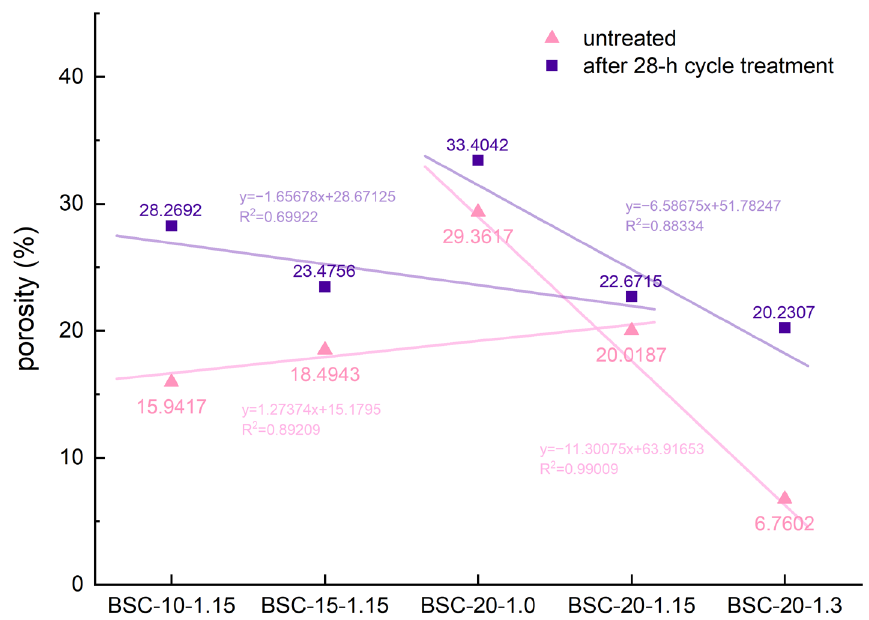
Figure 9. Porosity of the BSC samples before and after 28-h cycle treatment. Table 3. D -values of BSC samples.